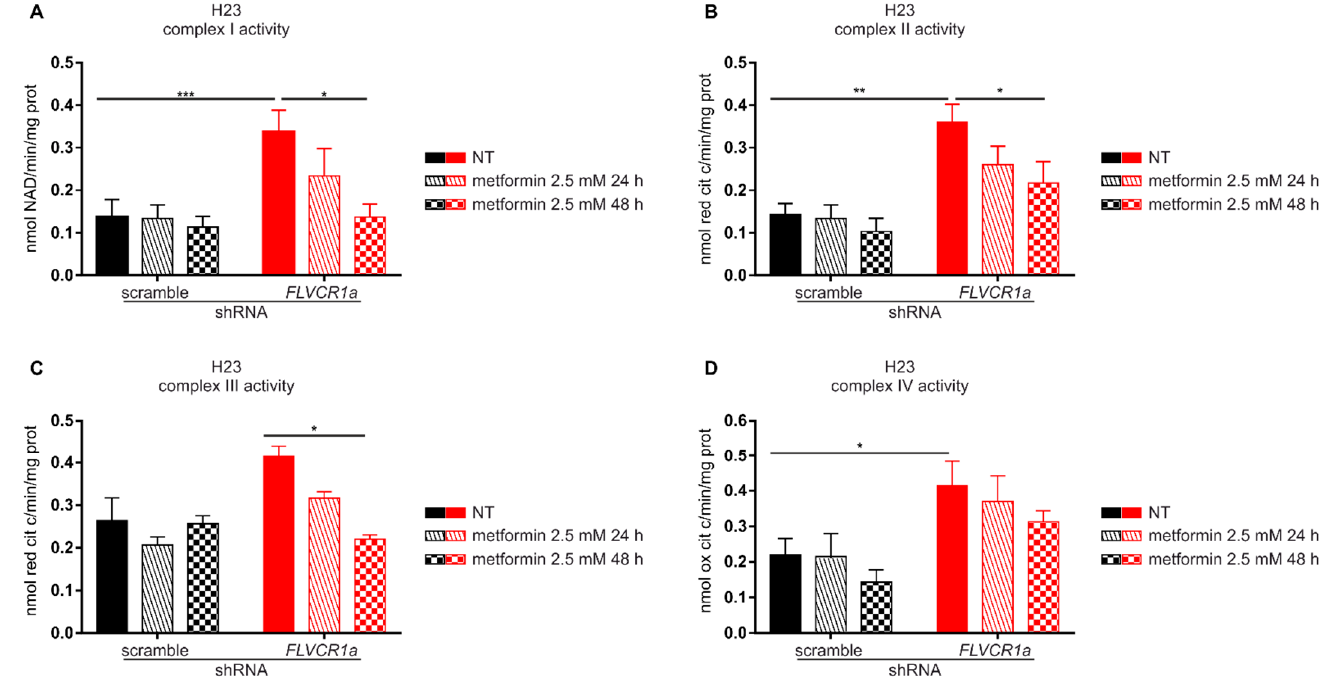
Figure 4. Metformin decreases ETC complexes activity in FLVCR1a -silenced cells. Activities of the mitochondrial electron transport chain complexes I–IV in H23 cells untreated (NT) and treated with 2.5 mM metformin for 24 or 48 h. FLVCR1a -silenced H23 cells are compared with cells